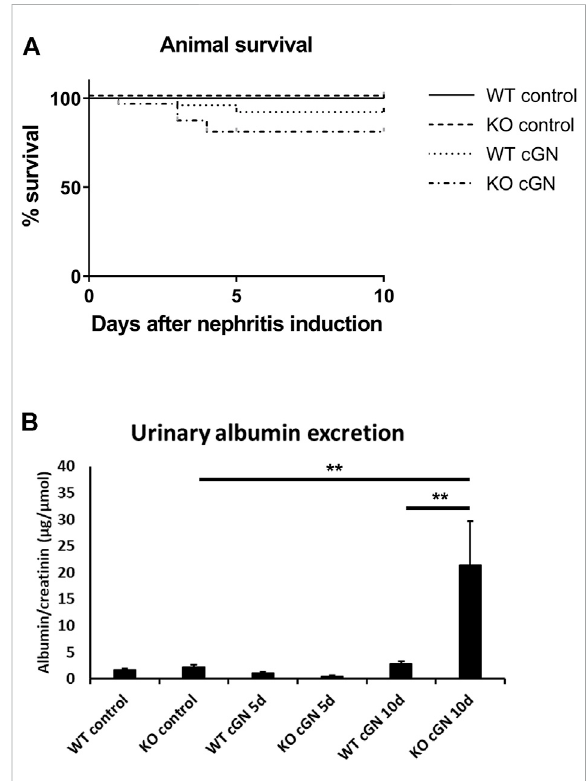
FIGURE 2 Survival and proteinuria. (A) Kaplan-Meier curves showing survival of wildtype (WT) and annexin A1-de fi cient (KO) mice after induction ofcrescentic glomerulonephritis (cGN) or after injection of normal sheep serum (control). (B) Quanti fi cation ofurinary albumin-to-creatinineratioincontrolmiceandatd5andd10after cGN induction. Statistical analysis of differences between survival curveswasperformedusingMantel-Coxlog-ranktest;proteinuria data was analyzed using two-way ANOVA; n = 5 – 8 per